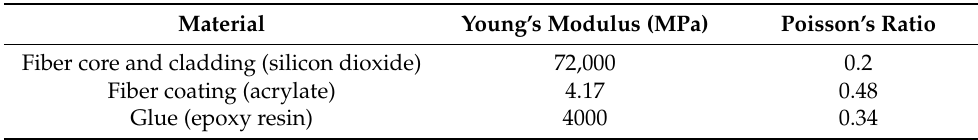
Figure 3. Schematic of experiment setup for detecting cracks with long distributed optical fiber sensors. Table 1. Mechanical parameters of distributed optical